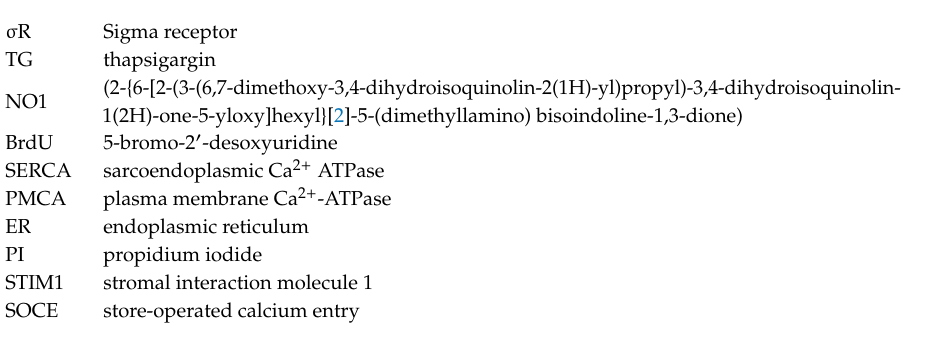
Figure S1: NO1 colocalization with STIM1 and σ 2R / TMEM97, Figure S2: σ 2R / TMEM97 does not colocalize with mitochondria, Figure S3: NO1 evokes the activation of di ff erent caspases in MDA-MB-231 cells, Figure S4: Caspase 9 inhibitor prevents NO1-evoked cells death, Figure S5: NO1 and SM21 alter Ca 2 + homeostasis in MDA-MB-231 cells, Figure S6: E ff ect of SM21 in the PMCA activity, Video S1: NO1 uptake and e ff ects in the MDA-MB-231 cells, Video S2: NO1 uptake and e ff ects in the MCF10A, Video S3: NO1 uptake and e ff ects in the NG115-401L